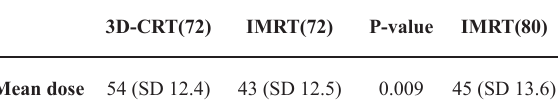
Table 4: Mean dose to penile bulb.